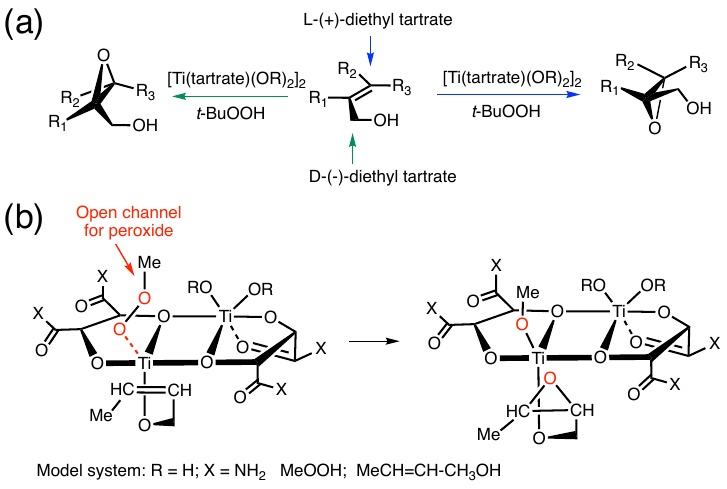
Figure 3. ( a ) General scheme of the Sharpless reaction; ( b ) model system investigated in this